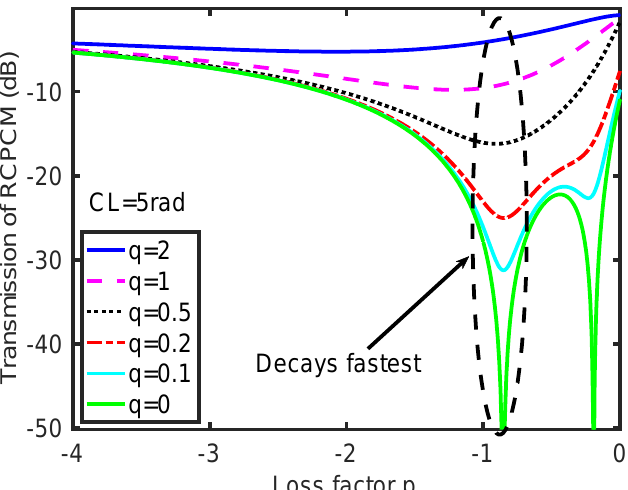
Figure 3. Variation in the transmission of the RCPCM with loss factor p for different detuning factors q .